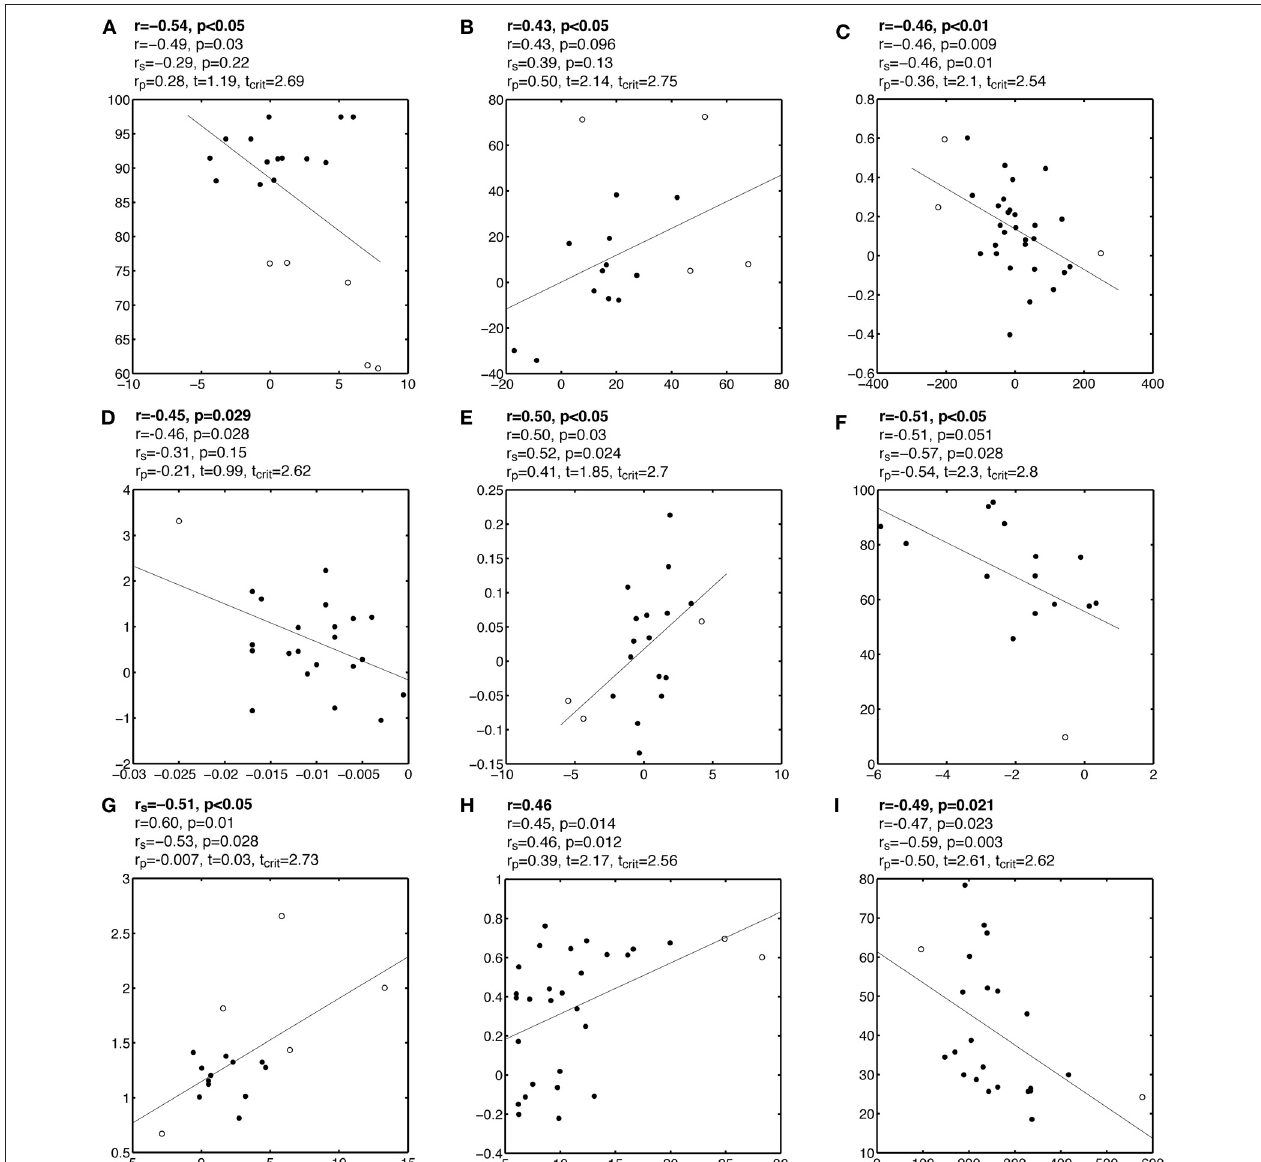
FIGURE A2 | Examples of false correlations potentially due to outliers. See Figure A1 caption for